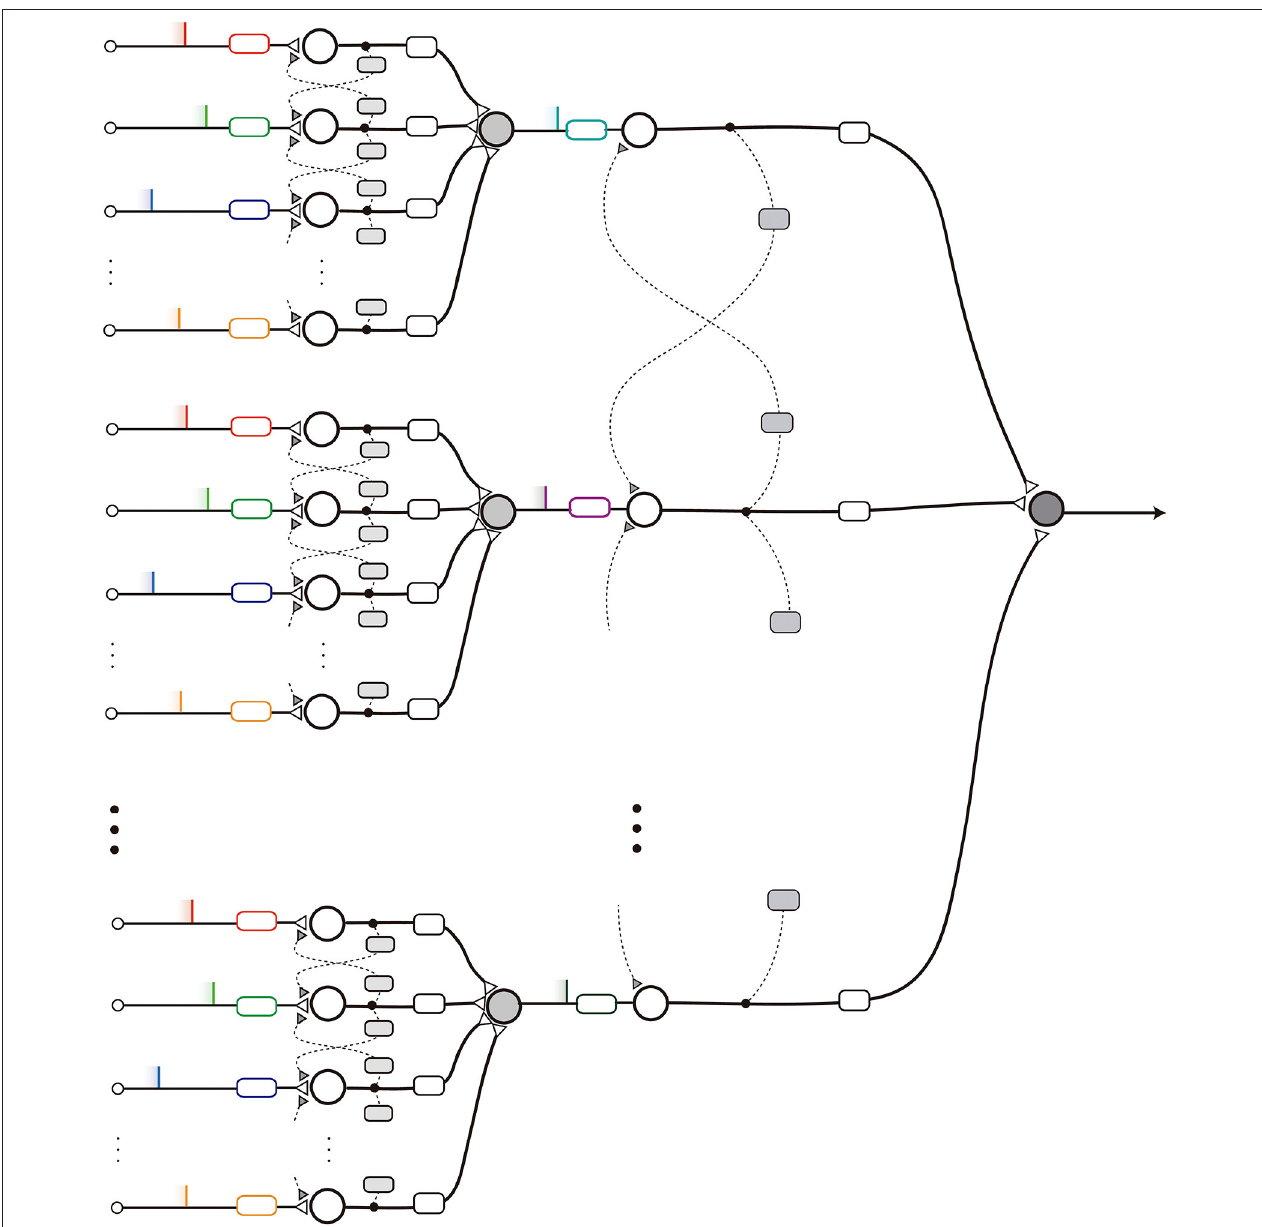
FIGURE 8 | Scheme of a layered nMNSD-based